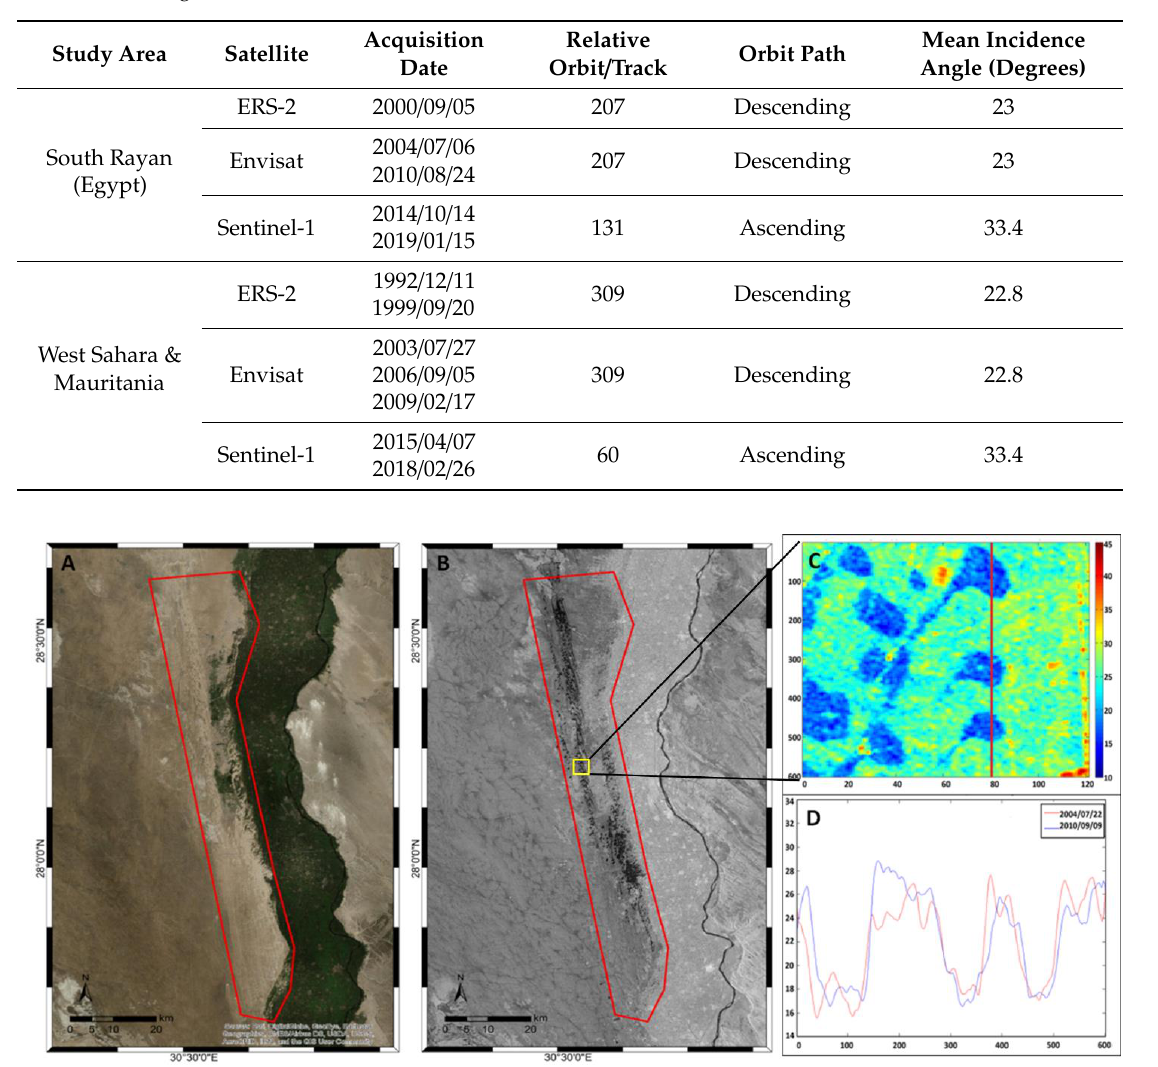
Figure 5. Overview of the methodological approach with the three steps discussed in the text.